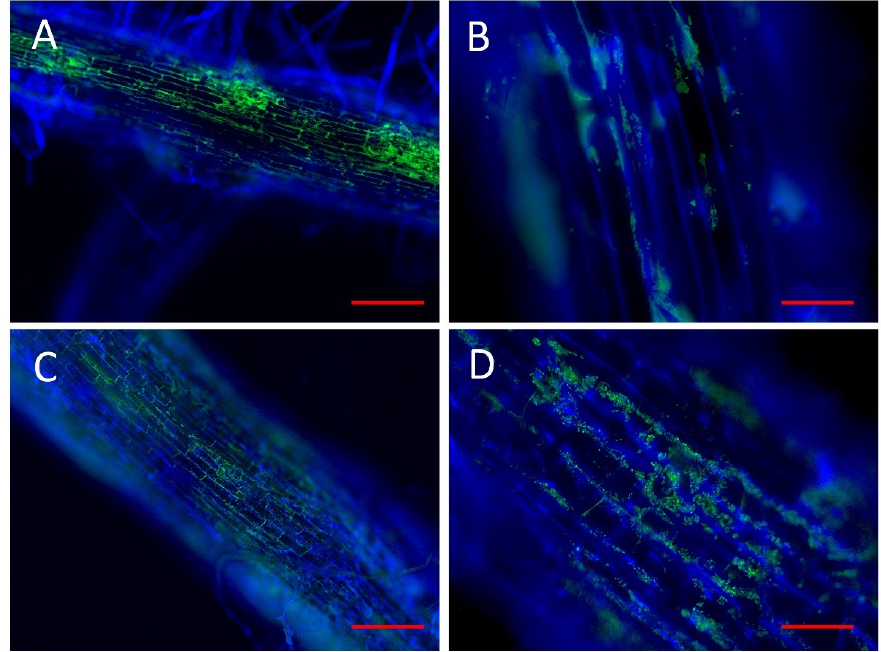
Figure 6. Fluorescence optical micrographs of roots of the blueberry seedlings colonized by Paraburkholderia domus VMSES31 (( A )-bar = 500 µm, ( B )-bar = 75 µm), Caballeronia jiansuensis VMFR53 (( C )-bar = 500 µm, ( D )-bar = 75 µm). In green are the bacterial cells of the studied strains and in blue the root cells stained with calcofluor white.